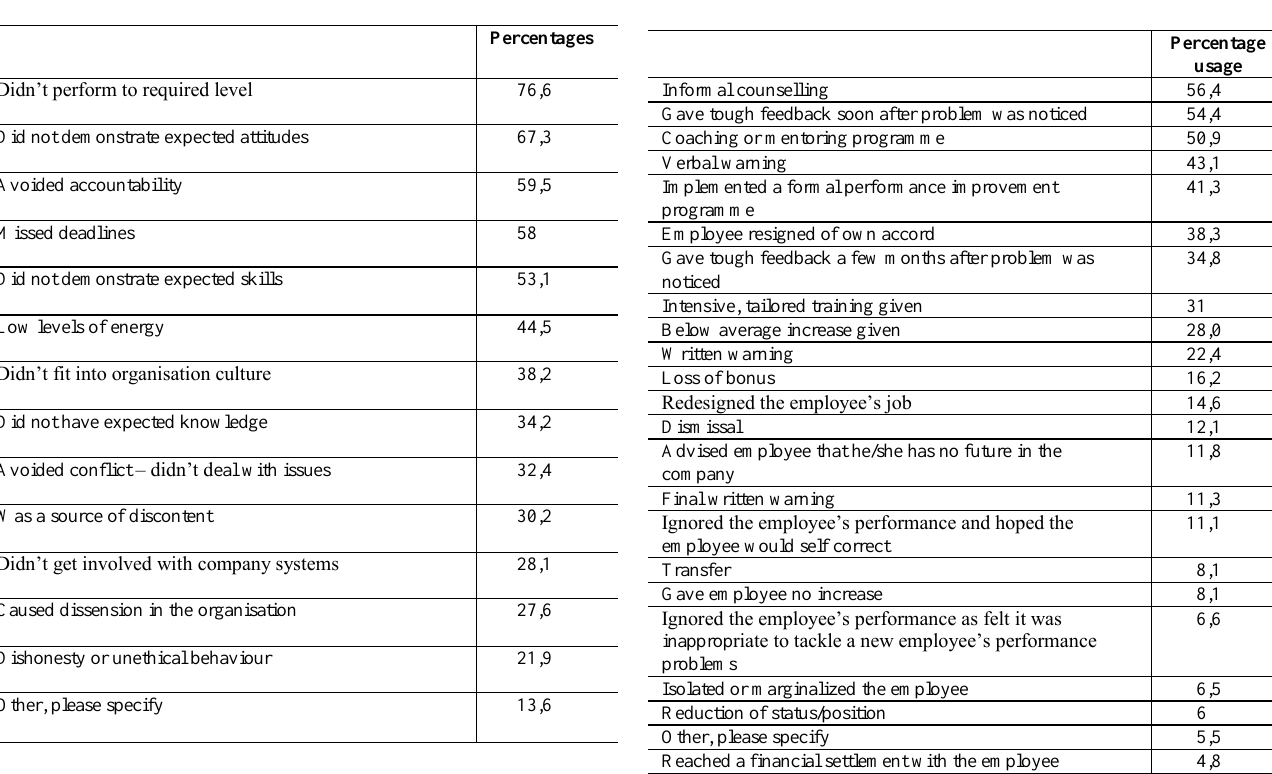
Table 4: Evidence that appointee was not suitable